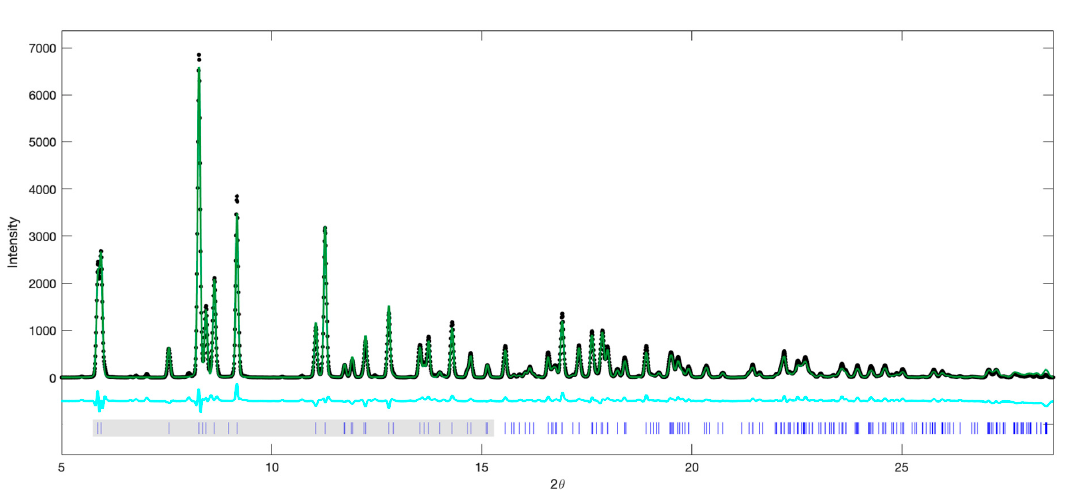
Figure 1. Integrated ambient pressure-temperature diffraction pattern with predicted reflections for szomolnokite. The background-corrected integrated pattern (black dots) is fit using Rietveld refinement in GSAS-II. The resulting fit is shown in green with residuals below (cyan). Predicted reflections for the monoclinic C 2/ c phase are shown in blue. The reflections highlighted in the grey region are chosen to calculate the ambient pressure lattice parameters: a = 7.09 Å, b = 7.55 Å, c = 7.78 Å, β = 118.65(2)°, volume = 365.2(1) Å 3 . Comparison to previous studies are shown in Table S1.